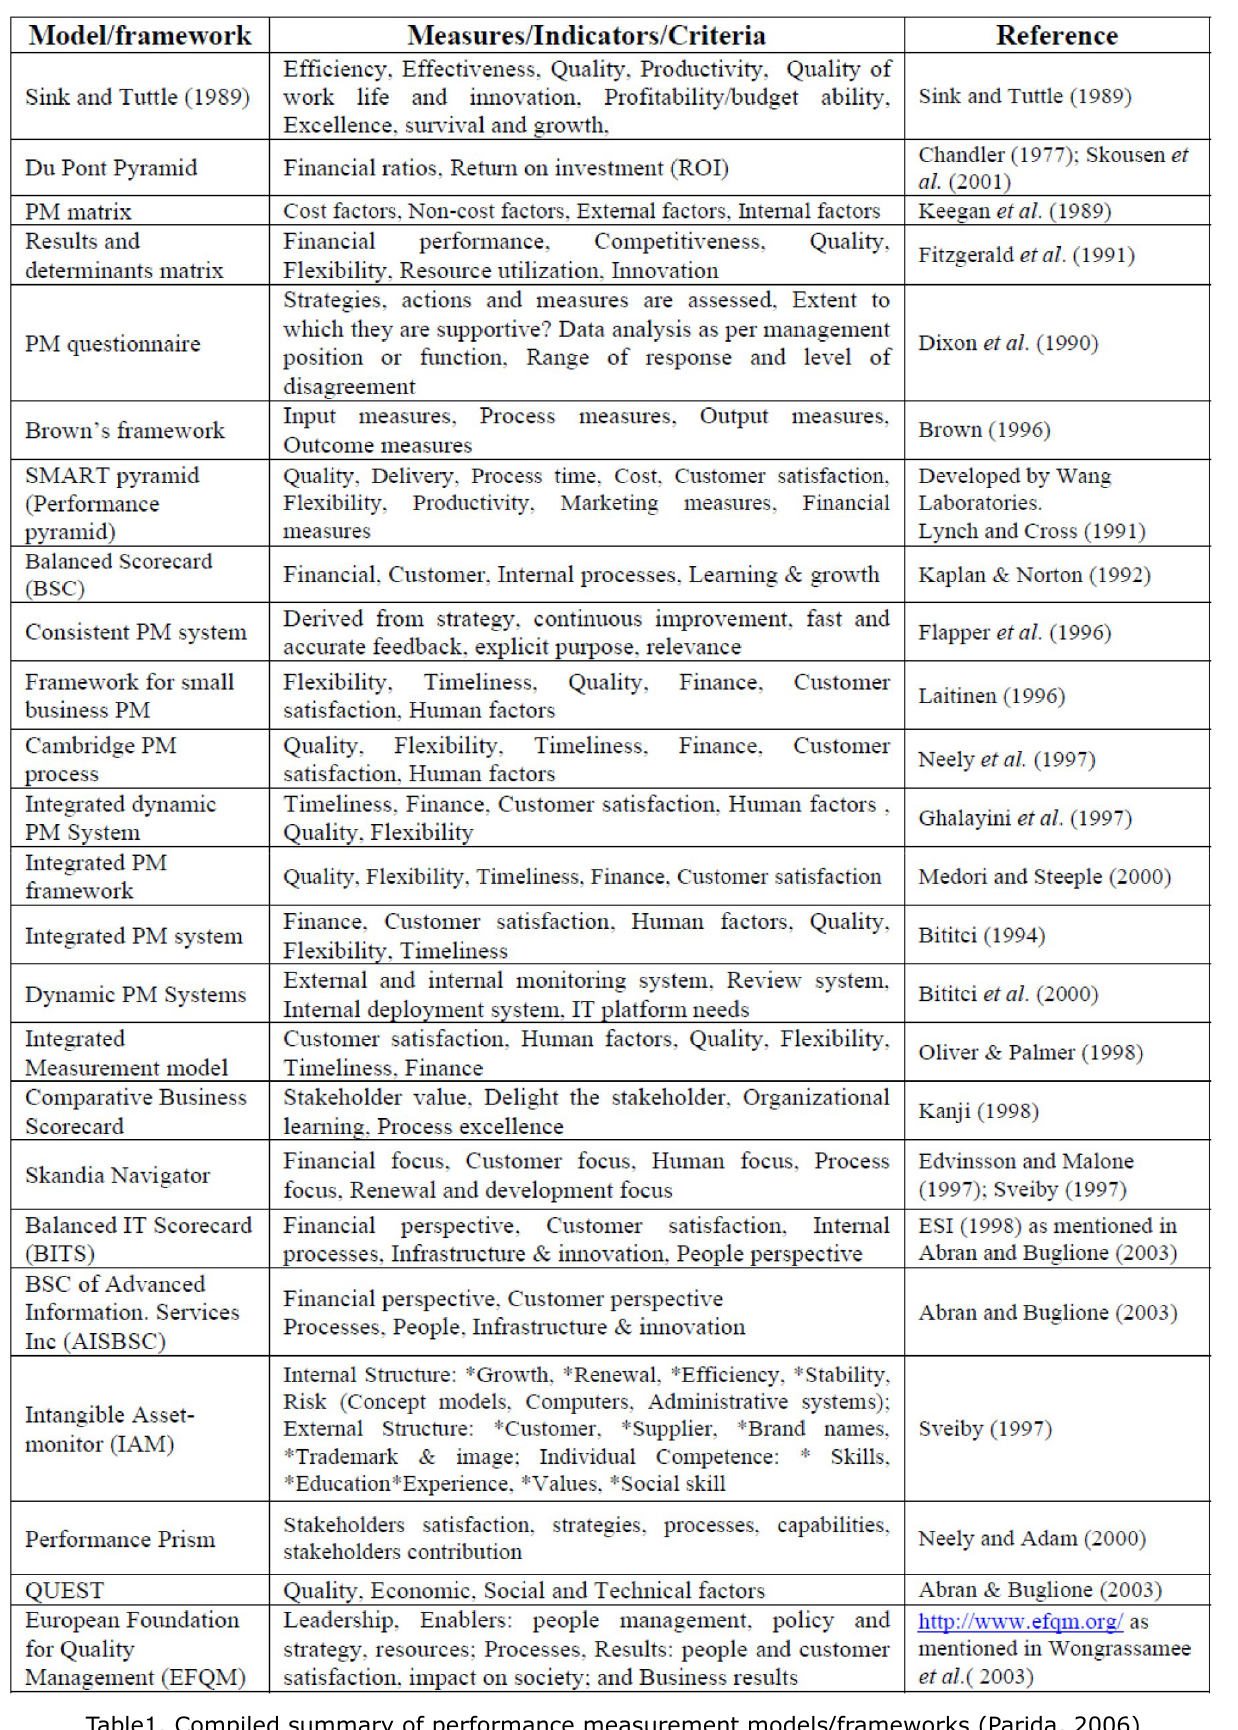
Table1. Compiled summary of performance measurement models/frameworks (Parida,